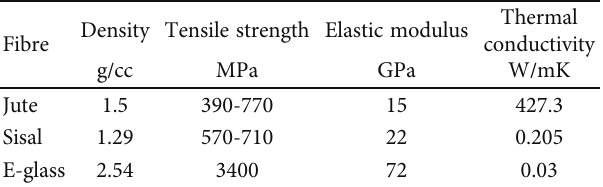
Table 1: Physical, mechanical, and thermal properties of jute/sisal/ and E-glass fi